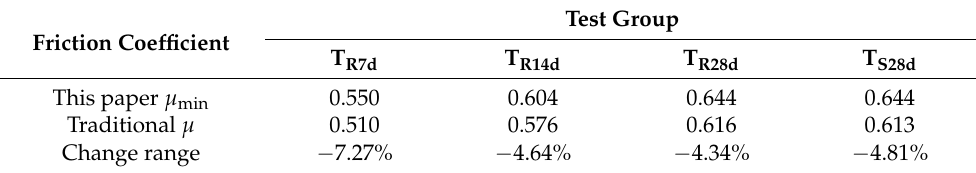
Table 2. Comparison of the minimum friction coefficient of the interface.